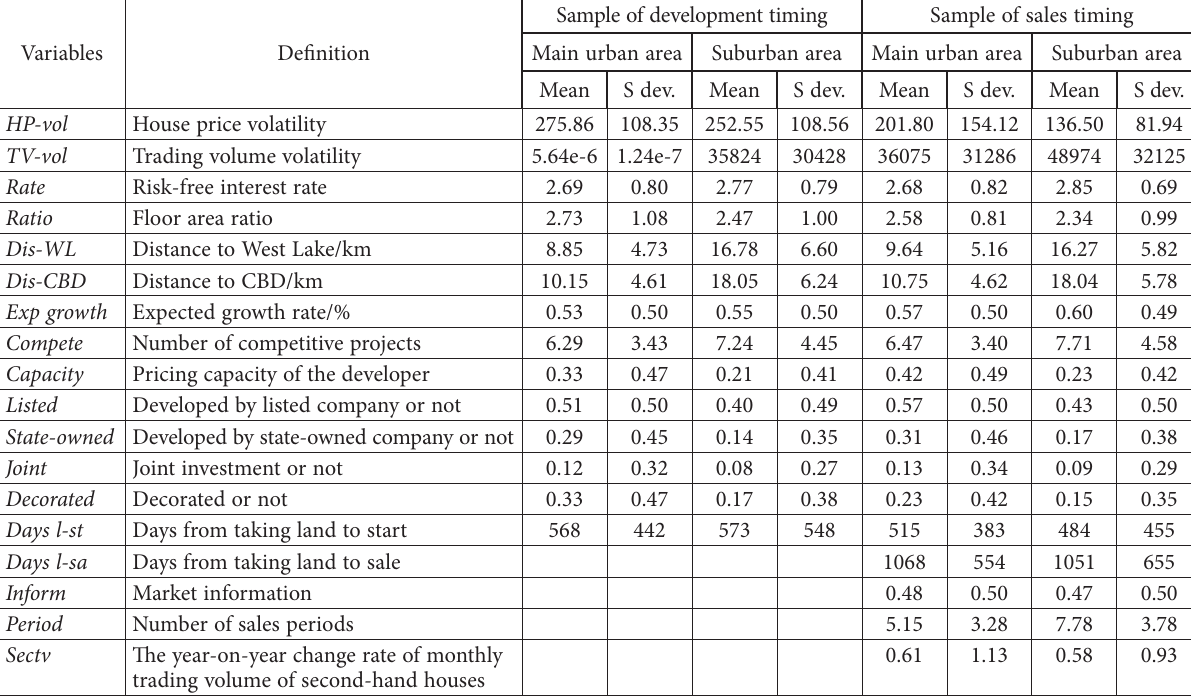
Table 1. The descriptive statistics of the